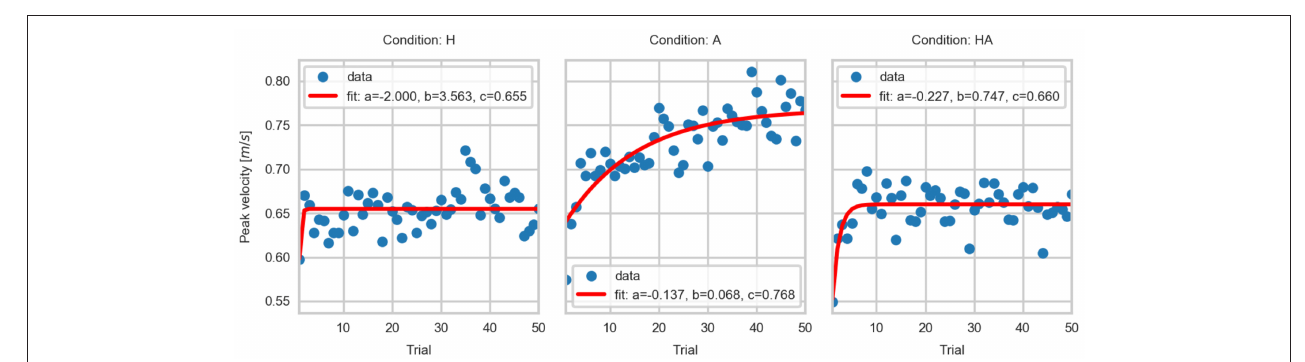
FIGURE 13 | Exponential fits to the peak velocity